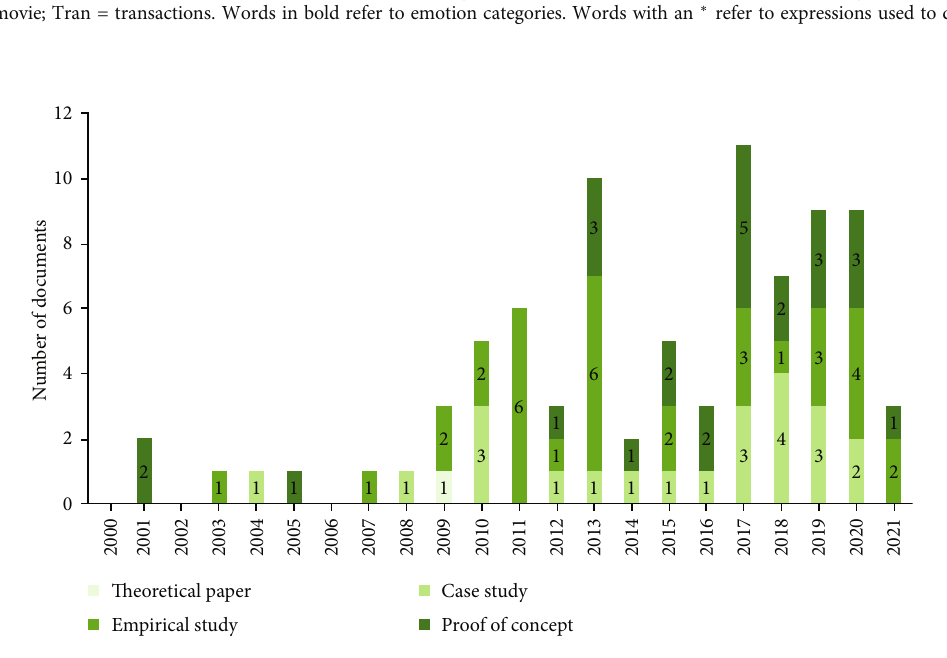
Figure 2: Number of publications by year as a function of study